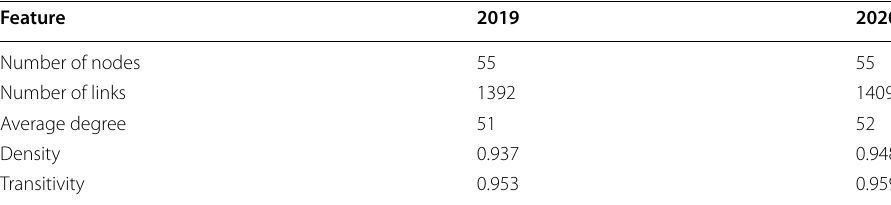
Table 1 Global network indicators of the WTN for 2019 and 2020